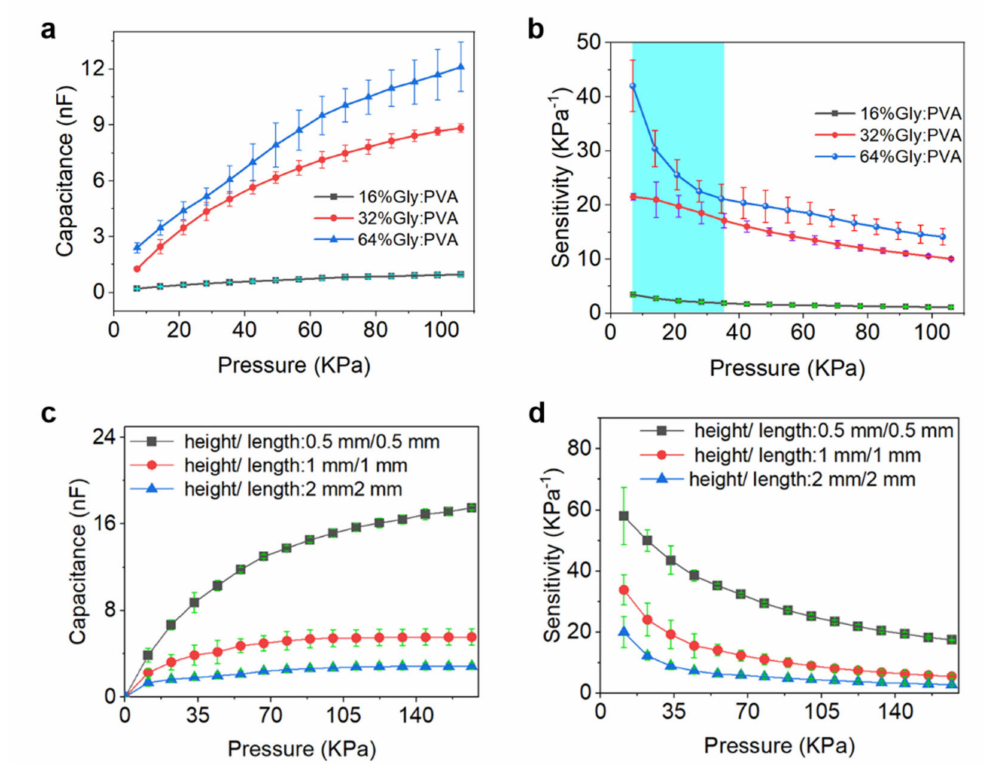
Figure 4. Component regulation and structural regulation of the iontronic pressure sensors. ( a , b ) Capacitance variations ( a ) and sensitivity variations ( b ) of the iontronic pressure sensors fabri- cated with electrolytes of different Gly/PVA ratios (16%, 32%, and 64%, respectively). Electrolyte of 32% Gly:PVA ratio are used to construct the sensors in the following measurements unless otherwise specified. ( c , d ) Capacitance variations ( c ) and sensitivity variations ( d ) of the iontronic pressure sensors fabricated using electrolytes with different geometrical parameters (the height/length of the micro-tetrahedrons is 0.5 mm, 1 mm, and 2 mm,